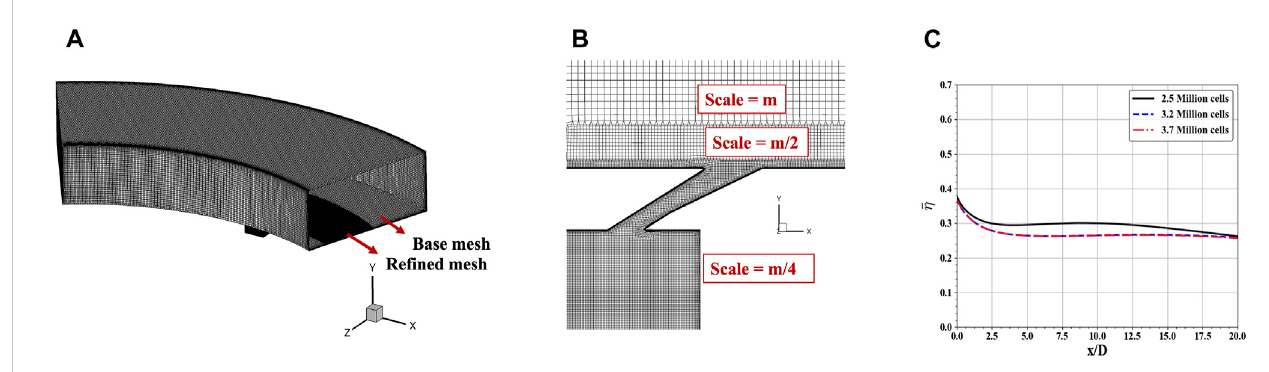
FIGURE 6 Hex-dominated unstructured mesh (A,B) and the grid independence test (C) .